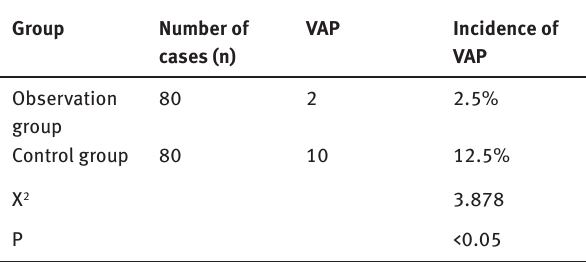
Table 2: Comparison of incidence of VAP between two groups (n)